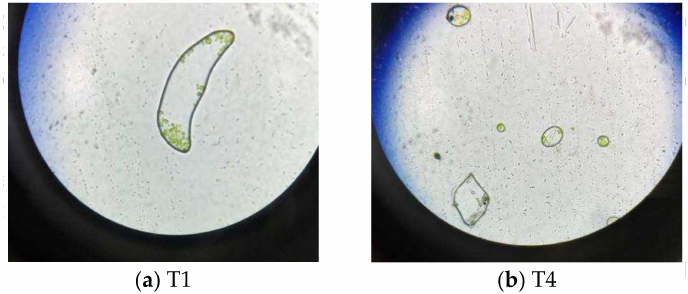
Figure 8. ( a ) Chlorella vulgaris under normal conditions; ( b ) Chlorella in reactor T4 with graphene